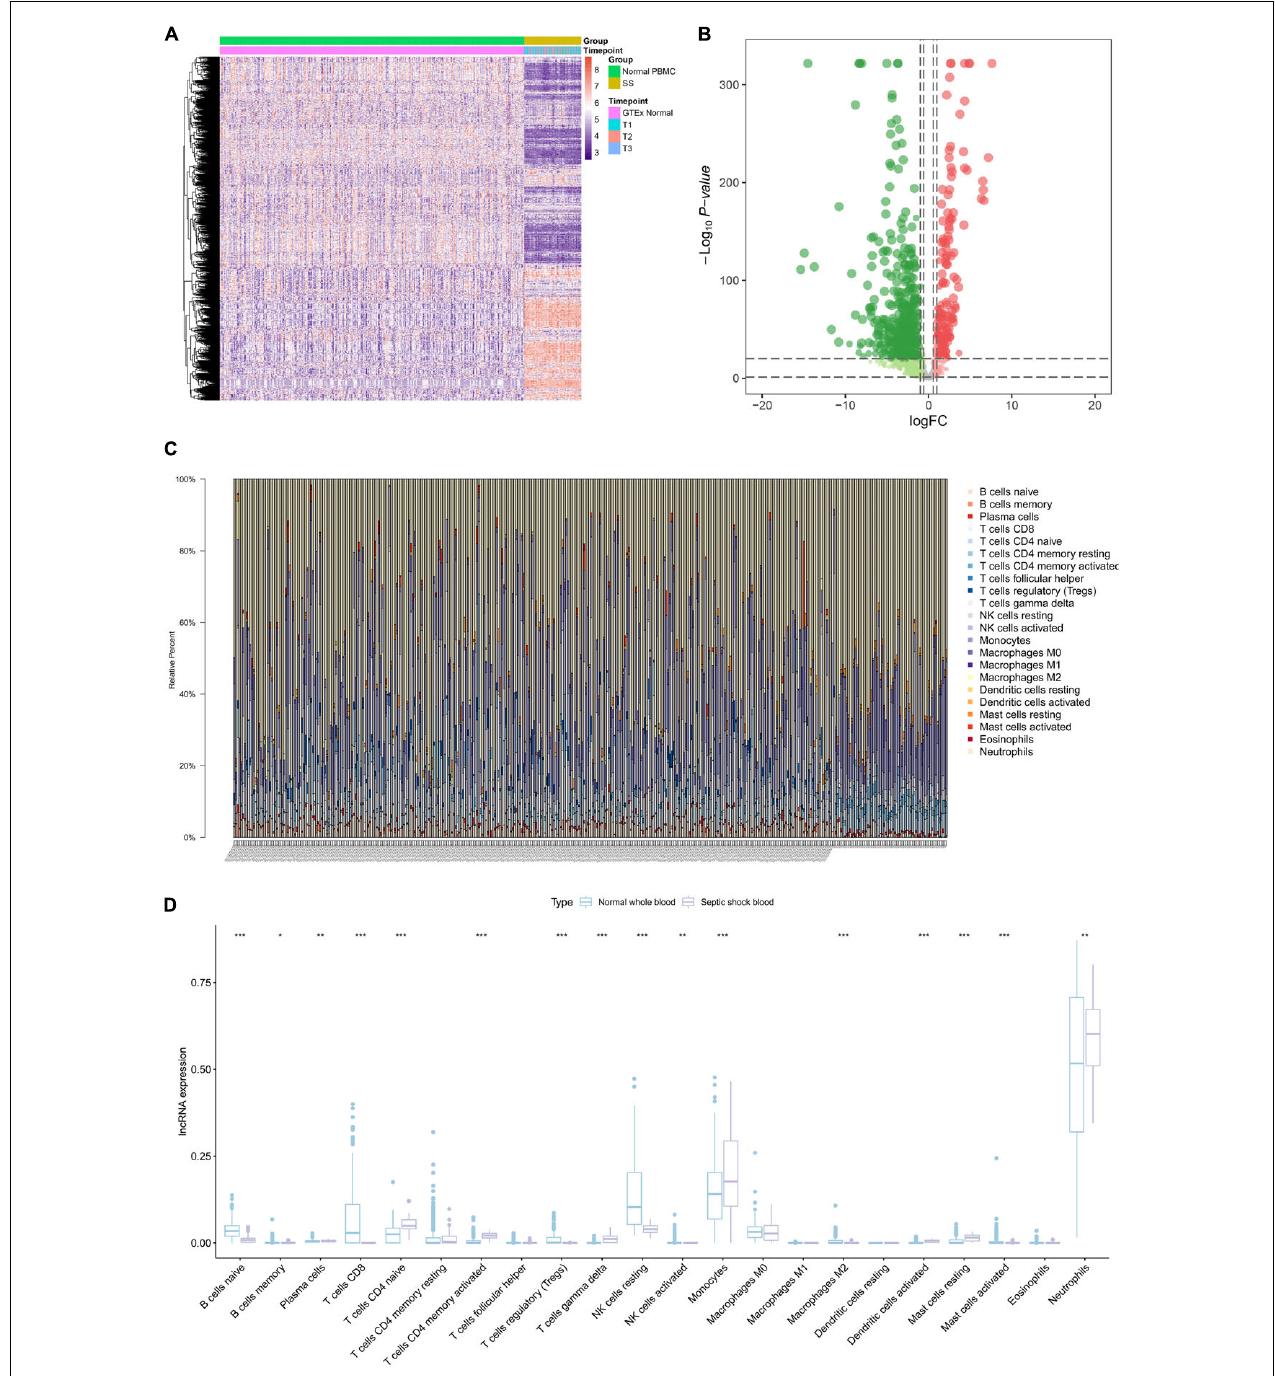
FIGURE 3 | The results of differential expression genes analysis of 2,498 IRGs and CIBERSORT algorithm analysis. (A) Heat map showing the expression level of differentially expressed septic shock-specific immune-related genes (SSSIRGs). A total of 839 SSSIRGs (666 down-regulated genes and 173 up-regulated genes) were identified as the intersection of 14,843 DEGs and 2,498 IRGs in septic shock peripheral blood. (B) Volcano plot showing the differential expression patterns of SSSIRGs, where green dots refer to down-regulated genes while red dots refer to up-regulated genes. (C) Bar chart showing the percentage of 22 kinds of immune cells in each sample by estimating relative subsets of RNA transcripts (CIBERSORT). (D) Box plot showing the fraction of 22 immune cells in normal whole blood and septic shock blood by Mann–Whitney U test. The results suggested that B cells naïve ( p < 0.001), B cells memory ( p < 0.050), Plasma cells ( p < 0.010), T cells CD8 ( p < 0.001), T cells CD4 naïve ( p < 0.001), T cells CD4 memory activated ( p < 0.001), T cells regulatory (Tregs) ( p < 0.001), T cells gamma delta ( p < 0.001), NK cells resting ( p < 0.001), NK cells activated ( p < 0.010), Monocytes ( p < 0.001), Macrophages M2 ( p < 0.001), Dendritic cells activated ( p < 0.001), Mast cells resting ( p < 0.001), Mast cells activated ( p < 0.001), and Neutrophils ( p < 0.010) were differentially enriching between septic shock and normal whole blood samples. * p < 0.05, ** p < 0.01, *** p <